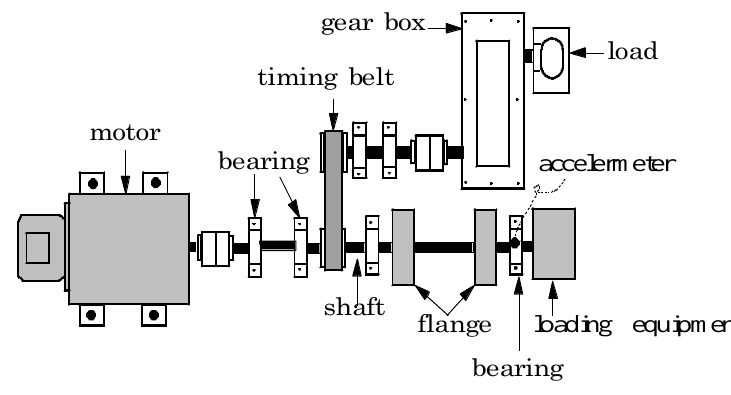
Figure 2. Experimental setup for rolling bearing fault diagnosis.